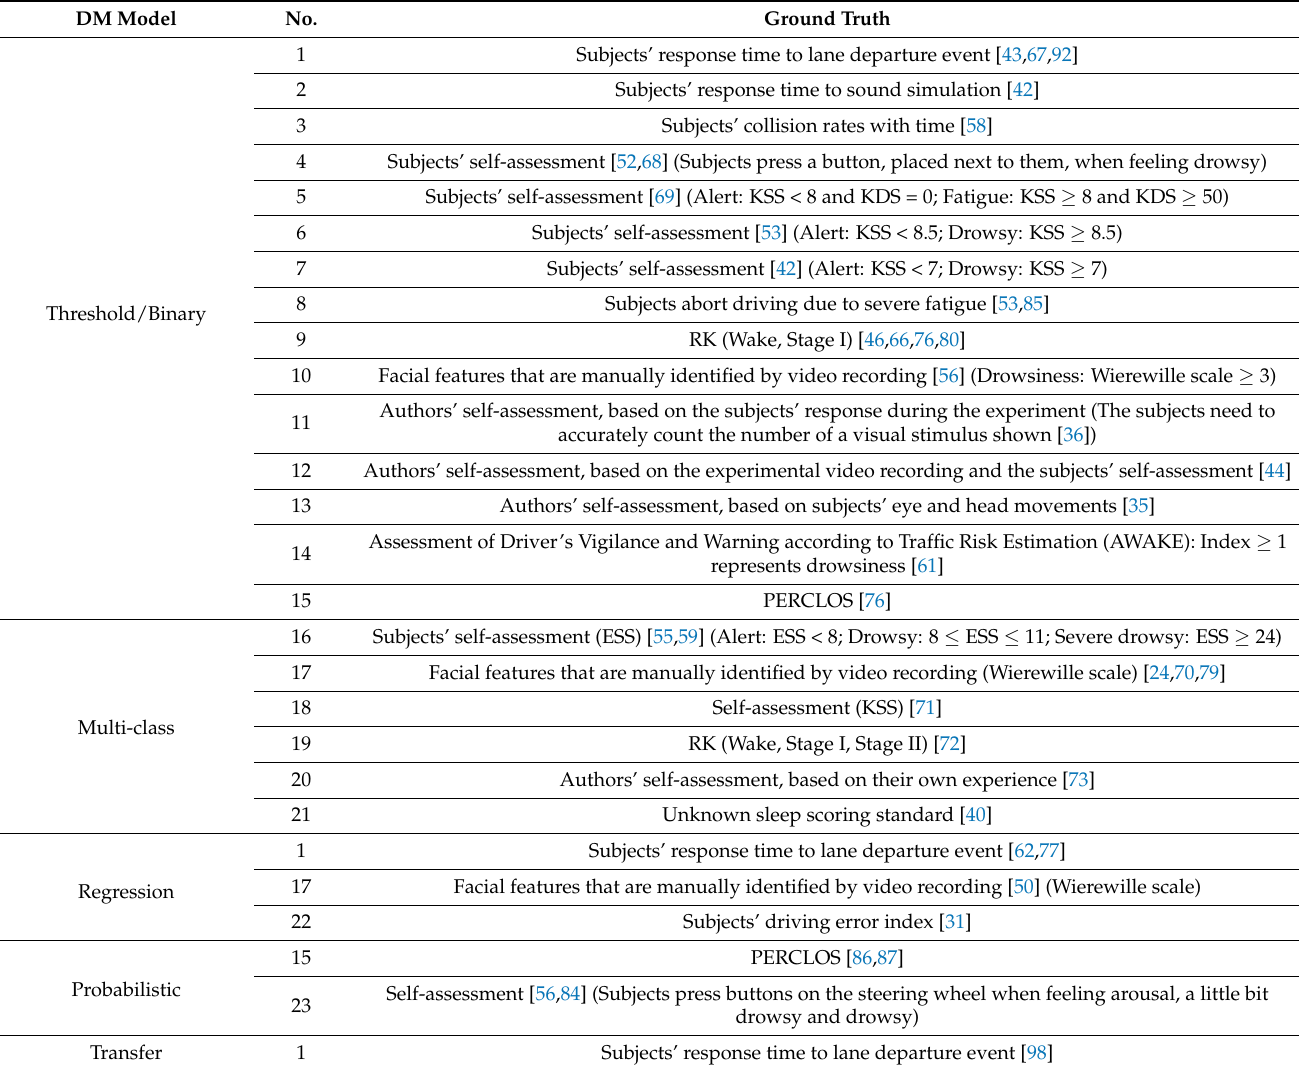
Table 4. Ground Truths used in EEG-based